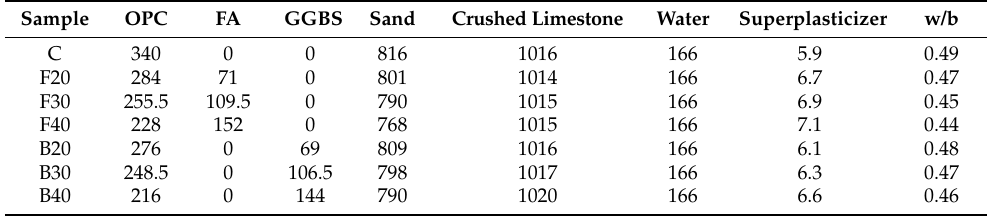
Table 2. Mix proportions of concrete (kg/m 3 ).